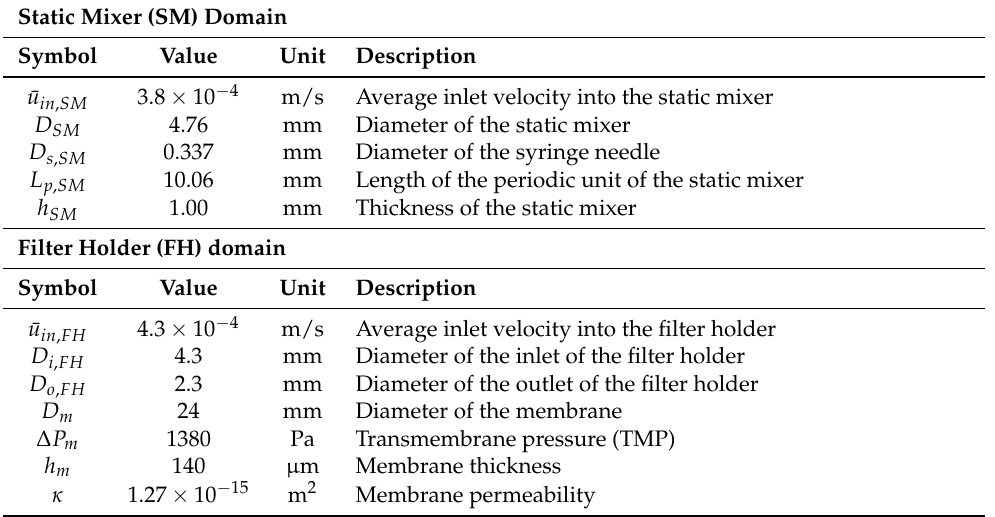
Figure 2. Processing units used in the transient inline spiking system and simulation domains for CFD simulation: ( a ) the geometry of the static mixer, ( b ) the periodic unit of the static mixer, and ( c ) the static mixer (SM) simulation domain in three dimensions composed of six periodic units of the static mixer and two buffer regions at the inlet and outlet. ( d ) The geometry of the filter holder, and ( e ) the filter holder (FH) in two dimensions with axisymmetry. A red single dash-dotted line in the simulation domain of the filter holder represents the axis of rotation. Table 2. Simulation